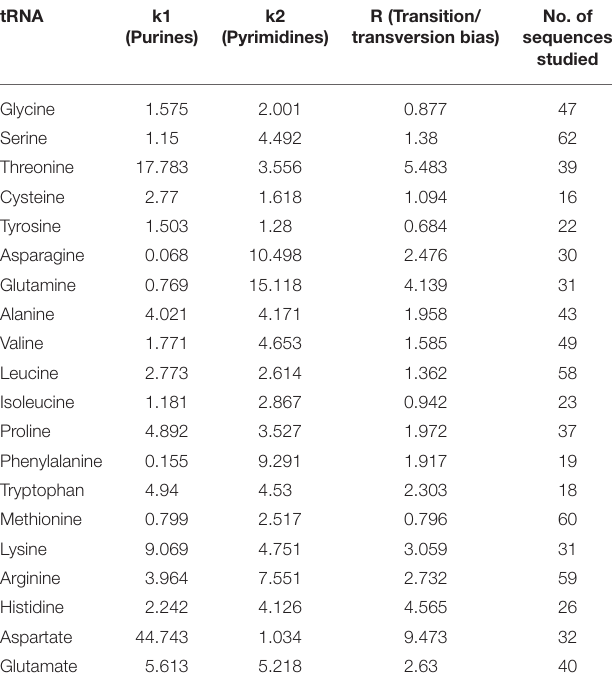
TABLE 7 | Transition/transversion bias of O. sativa tRNAs. tRNA k1 k2 R